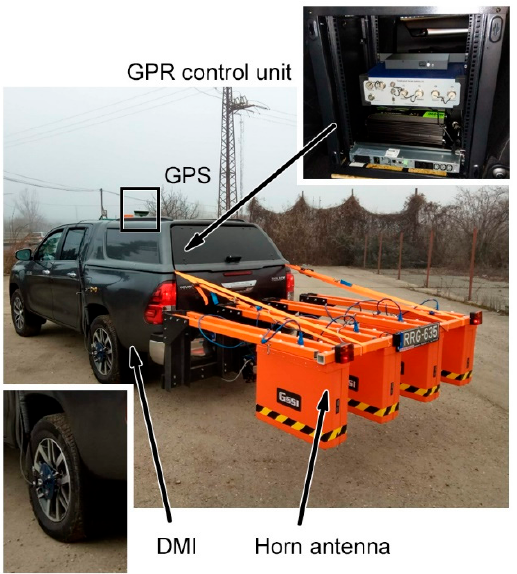
Figure 2. Main parts of the ground-penetrating radar (source: RODEN Engineering Office).